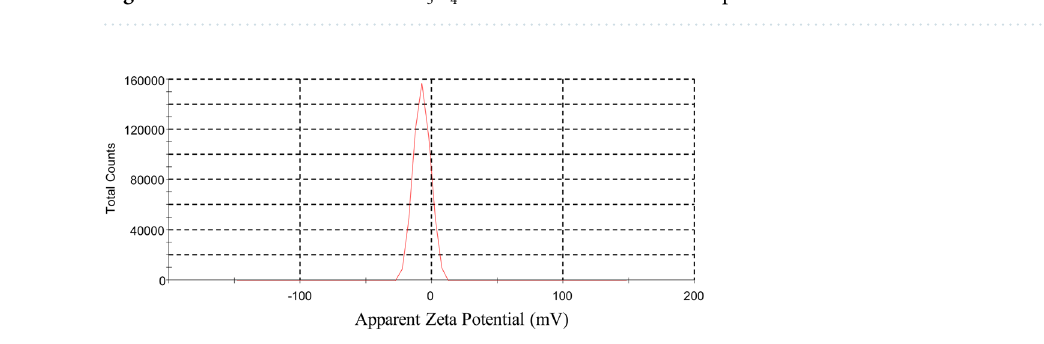
Figure 7. VSM measurements of Fe 3 O 4 and acid functionalized nanoparticles.